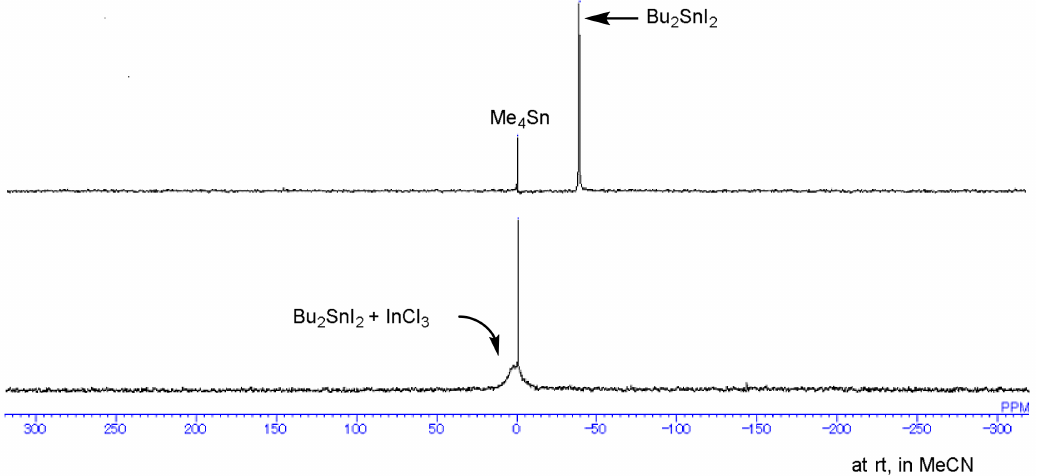
Figure 1. 119 Sn NMR of the tin-indium